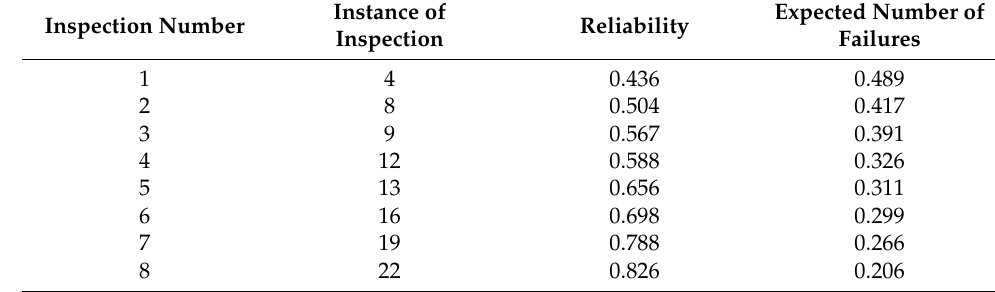
Table 3. Relationship between expected reliability and number of inspections.